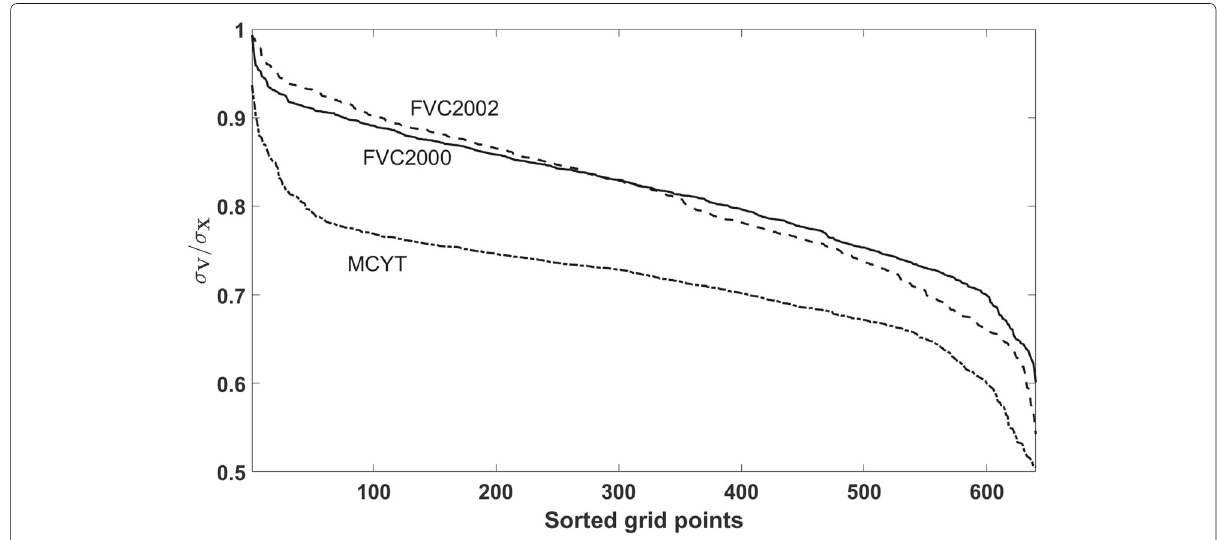
Fig. 7 Sorted noise-to-signal ratio of M x θ for different databases